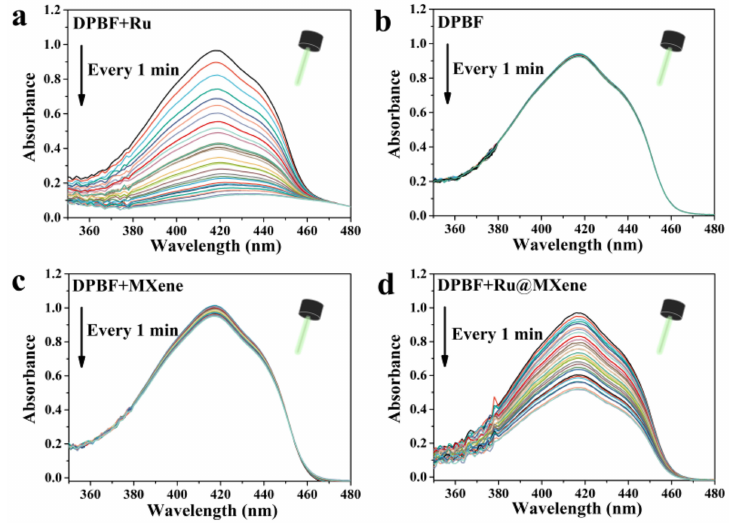
Figure 5. Decrease in absorbance spectra of DPBF for the detection of 1 O 2 in the presence of Ru ( a ); DPBF ( b ); MXene ( c ); and Ru@MXene ( d ) with 532 nm LED lamp illumination (20